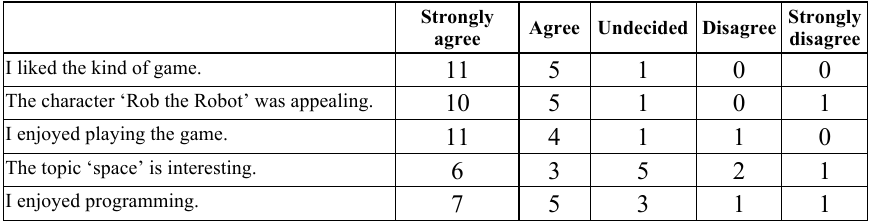
Table 3. Answers of the questions about the girls’ perception.